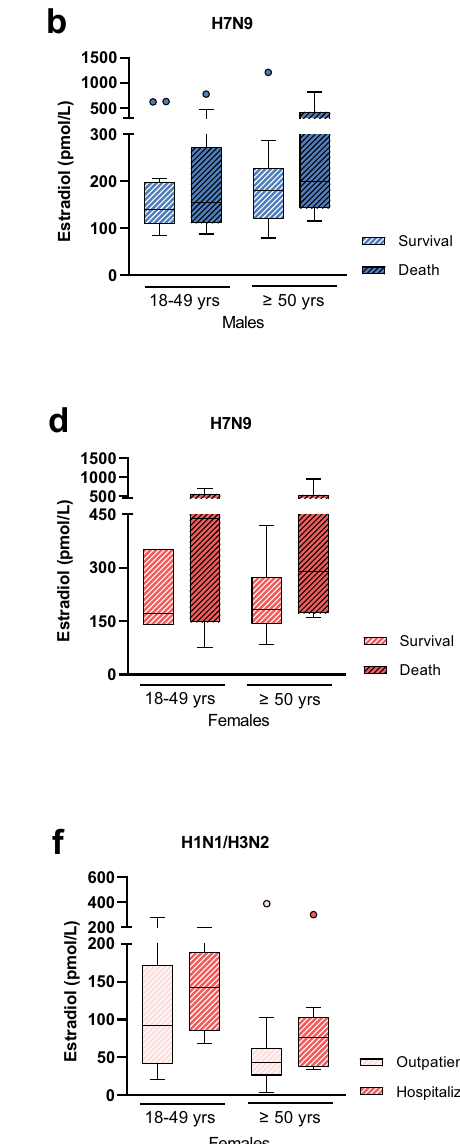
Fig.2|EstradiollevelsinH7N9-infectedpatientscomparedtocontrolcohorts. a Estradiol levels were measured in sera from H7N9 IAV-infected males (18 – 49yrs: n =32, ≥ 50yrs: n =27) and compared to male control groups as follows: (i) H7N9- negative poultry workers (18 – 49yrs: n =15, ≥ 50yrs: n =19) and (ii) H7N9-negative close contacts (18 – 49yrs: n =29, ≥ 50yrs: n =16); b Estradiol levels in H7N9 IAV- infected male patients were compared in dependency of disease outcome (18 – 49yrs survival/death: n =18/14, ≥ 50yrs survival/death: n =17/10); c Estradiol survival/death: n =3/6, ≥ 50yrs survival/death: n =6/6). e , f Estradiol levels were measured in plasma from seasonal in fl uenza-infected male (18 – 49yrs outpatient/ hospitalized: n =16/11, ≥ 50yrs outpatient/hospitalized: n =12/14) ( e ) and female